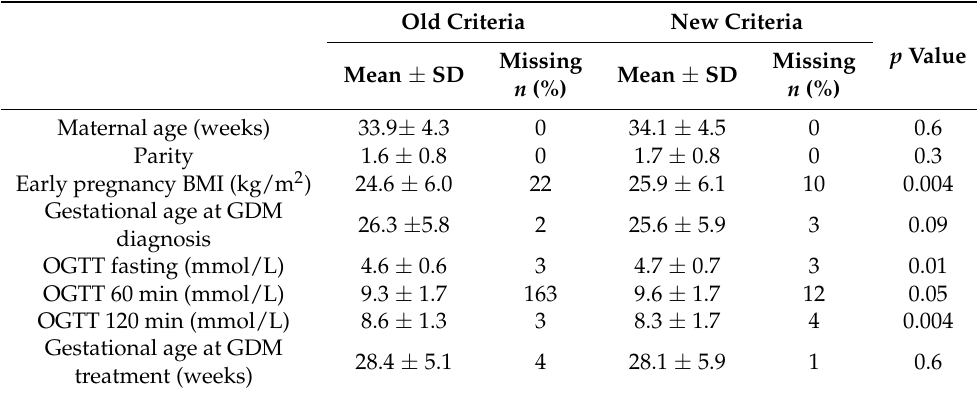
Table 1. Baseline demographics.